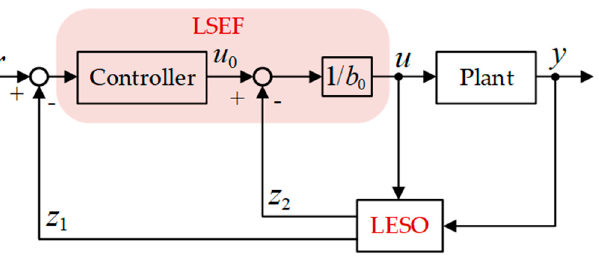
Figure 3. The structure diagram of the conventional LADRC, where z 2 provides a preliminary estimate of the generalized disturbance.